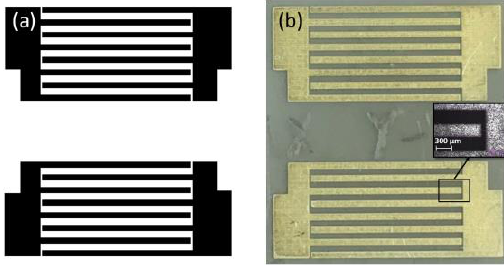
Fig. 2. Patterns of delay lines for lithium niobate crystal orientation YX (a) and corresponding photo with detailed inset